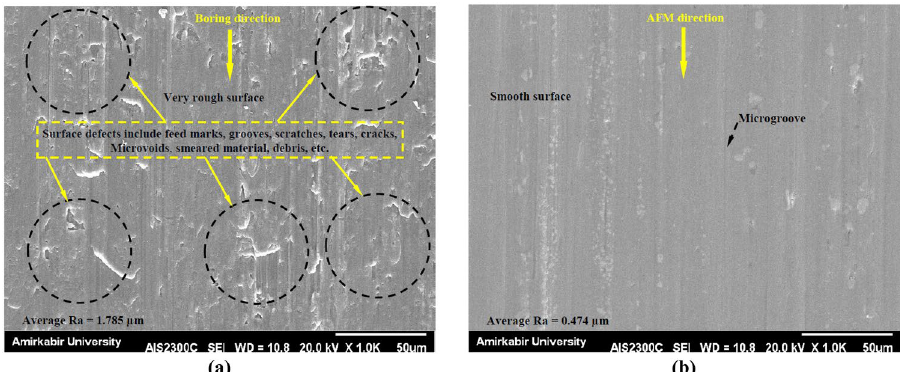
Fig. 7 The surface morphology of AA2024 tubes: a produced by the boring operation and b machined by the AFM